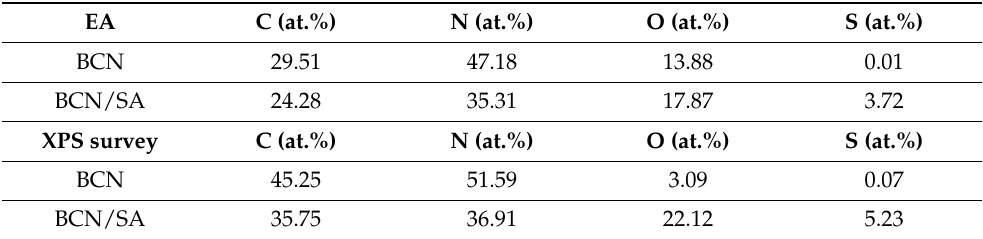
Table 1. The elemental atomic percentage in BCN and BCN/SA from elemental analysis (EA) (up), XPS survey scan